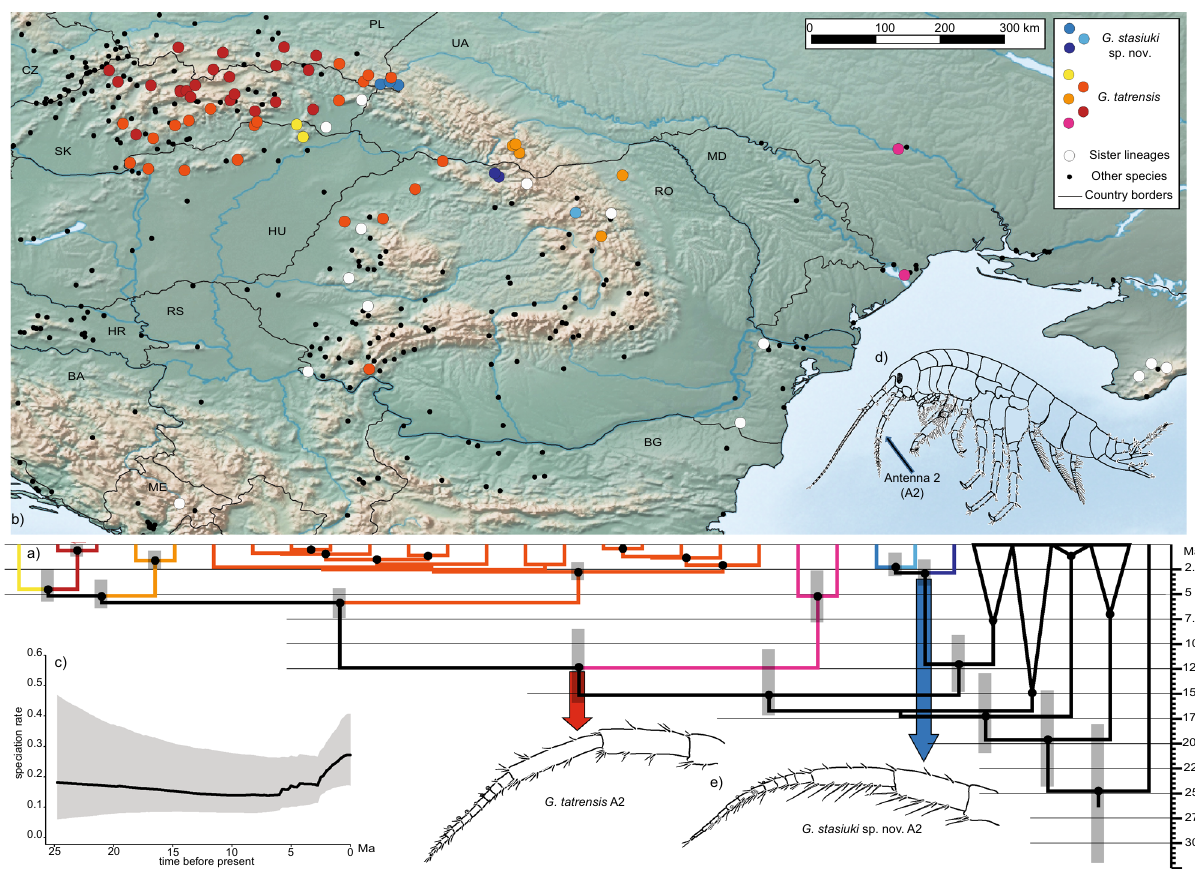
Figure 2. Phylogeny and distribution of G. tatrensis , G. stasiuki sp. nov and their sister lineages. ( a ) Time calibrated species phylogeny reconstruction based on the full multimarker data set generated in *BEAST. Species were defined using BINs (see Materials and Methods). White dots indicate nodes with a posterior probability (PP) > 0.75, grey bars on key nodes are showing a range of 95% HPD. Colours represent MOTUs. ( b ) Map of the Carpathians with sampling stations indicated by colour symbols. Colours represent MOTUs. White circles represent sister lineages of the studied species. Black dots represent sampling spots on which the studied group was not found (map constructed in QGIS 3—qgis.org, background obtained from: naturalearthdata.com). ( c ) Speciation rate through time inferred using BAMM tools. ( d ) General body shape of gammarid. ( e ) Antenna 2 of G. tatrensis and G. stasiuki sp.